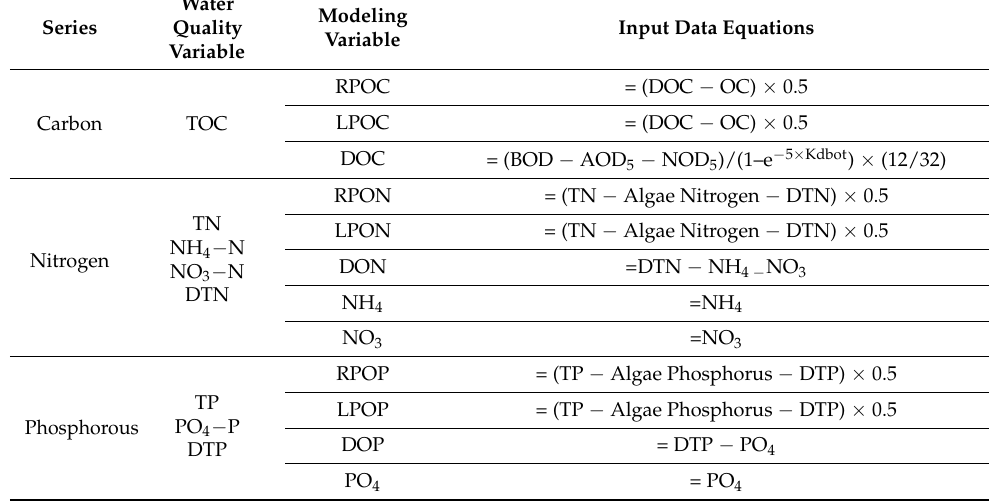
Table 1. Conversion equations for water quality observation data to be used as input data in the EFDC-NIER model.